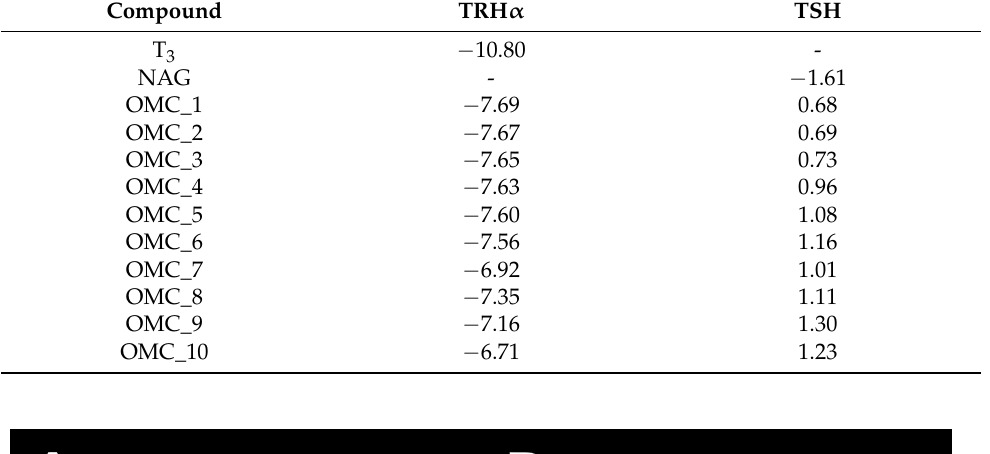
Table 2. Binding energies of ligands T3, NAG and OMC (1–10) calculated from molecular docking studies. Compound TRH α